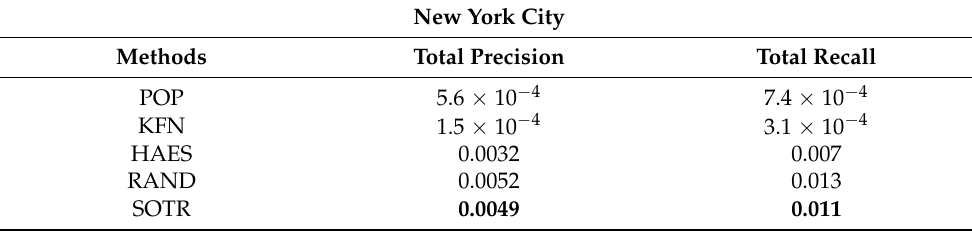
Table 8. The experimental results for New York City, addressing the cold-start problem using